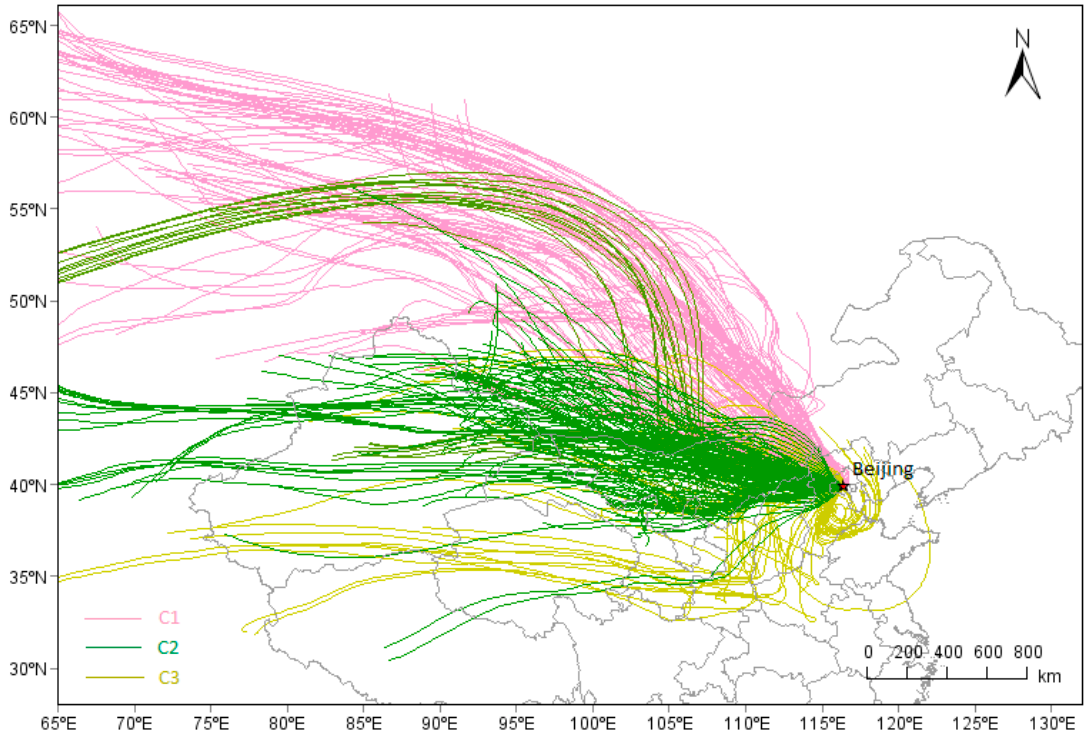
Figure 8. 72-h air particle backward trajectory clusters during heating season in Beijing. Cluster 1 (C1), Cluster 2 (C2), Cluster 3 (C3).